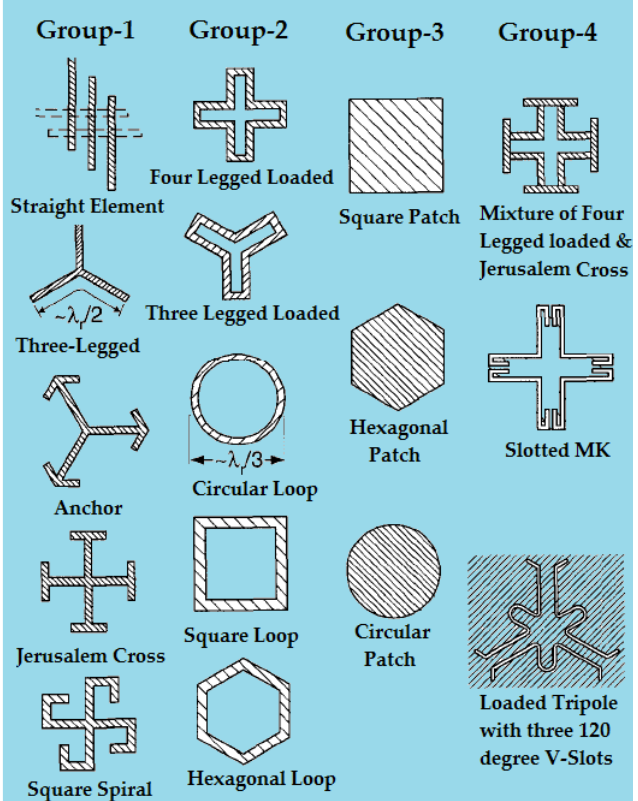
Figure 5. Typical shapes of FSS elements